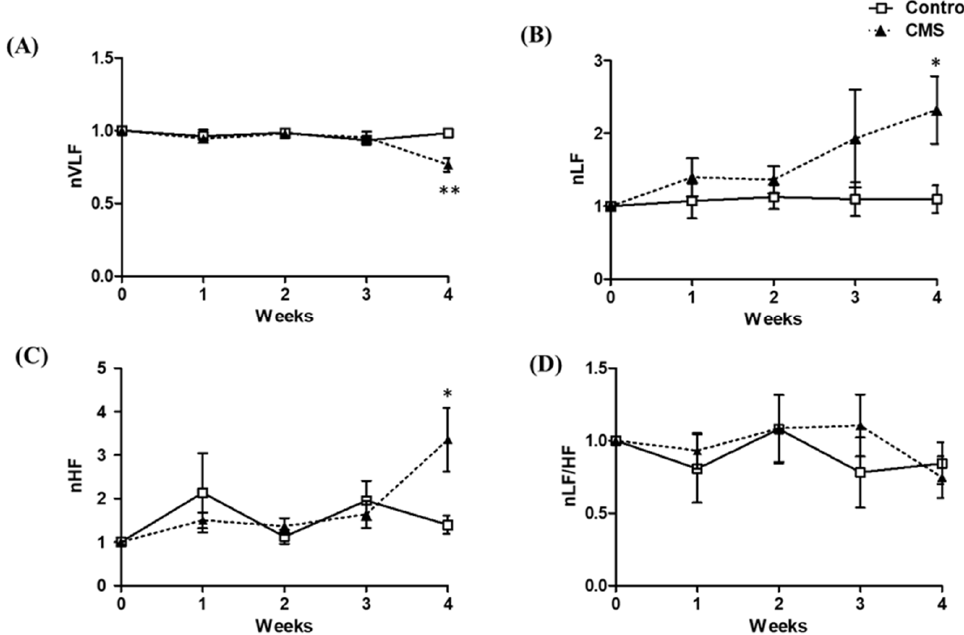
Figure 4. Normalized data of VLF ( A ), LF ( B ), HF ( C ) and LF/HF ratio ( D ) of control and CMS. Data are presented as mean + S.E.M., * p < 0.05 vs. control, ** p < 0.01 vs. control at the same time point, Student’s unpaired t -test; n = 7 for each group.